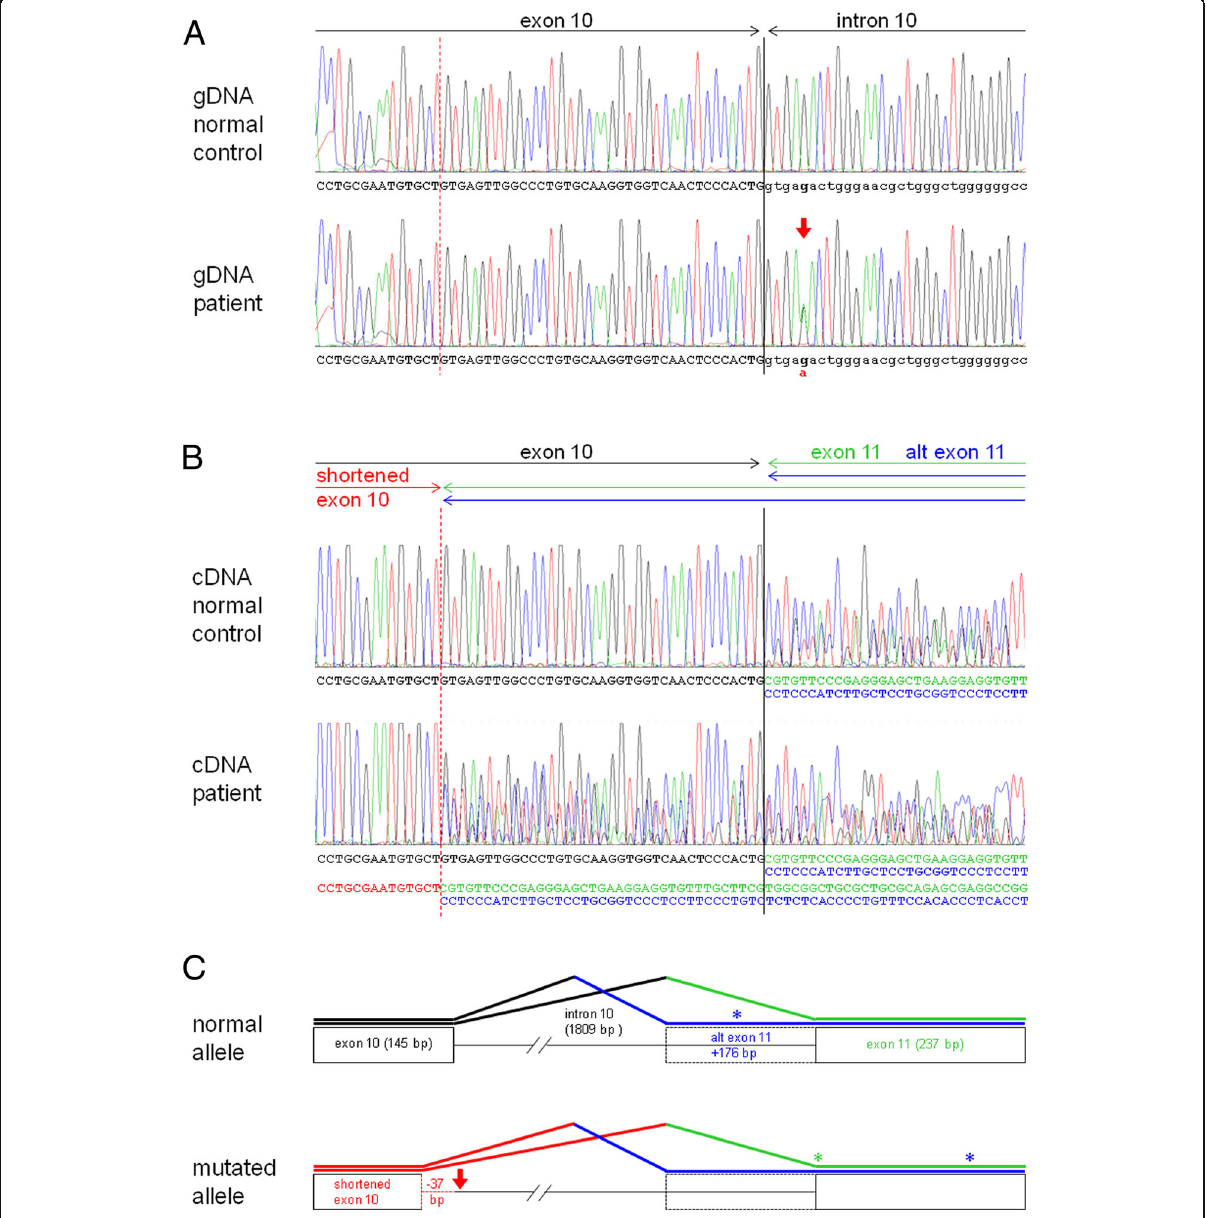
Fig. 2 Electropherograms of Sanger sequences of SYNGAP1 genomic DNA (gDNA) ( a ) and lymphocyte cDNA ( b ) of a representative normal control and the patient, and schematics of splicing of the exon 10 - exon 11 region in mRNA from the normal and mutated SYNGAP1 alleles ( c ). The variant in intron 10 is marked by a thick red arrow . The regular exon 10 - intron 10 boundary and the new splice donor site in exon 10 are indicated by a solid black vertical line and a dashed red vertical line , respectively. Black , red , green and blue lettering in ( b ) and thick lines in ( c ) correspond to regular splicing of exon 10, aberrant splicing of exon 10, regular splicing of exon 11 and alternative splicing of exon 11, respectively. Asterisks indicate premature stop